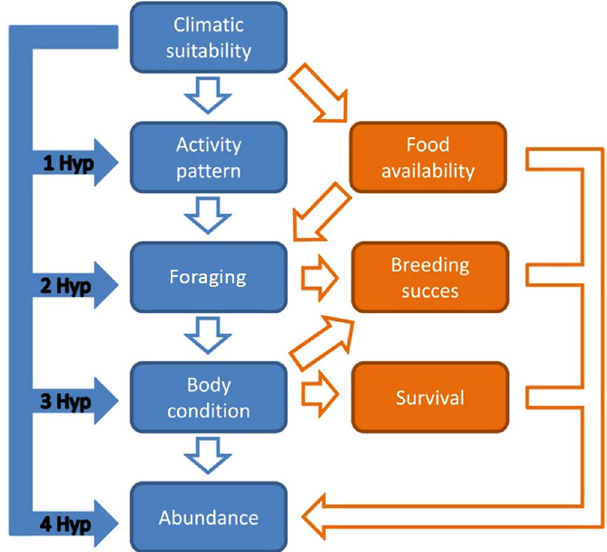
Figure 1. Potential relationships between climatic suitability, population parameters and species abundance. In blue the proposed pathways, in orange pathways for which no data are available in this study. Filled arrows represent hypotheses tested in the present